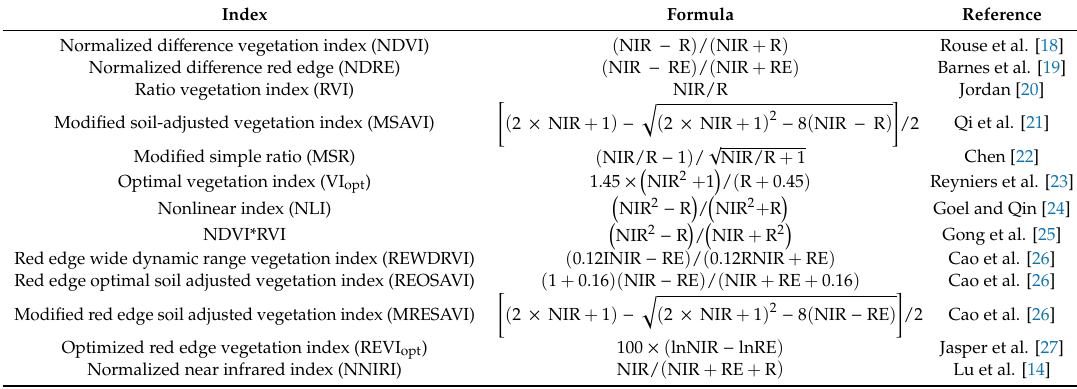
Table 2. NDVI, NDRE, and the best performing vegetation indices for calibration and validation from RapidSCAN used in this